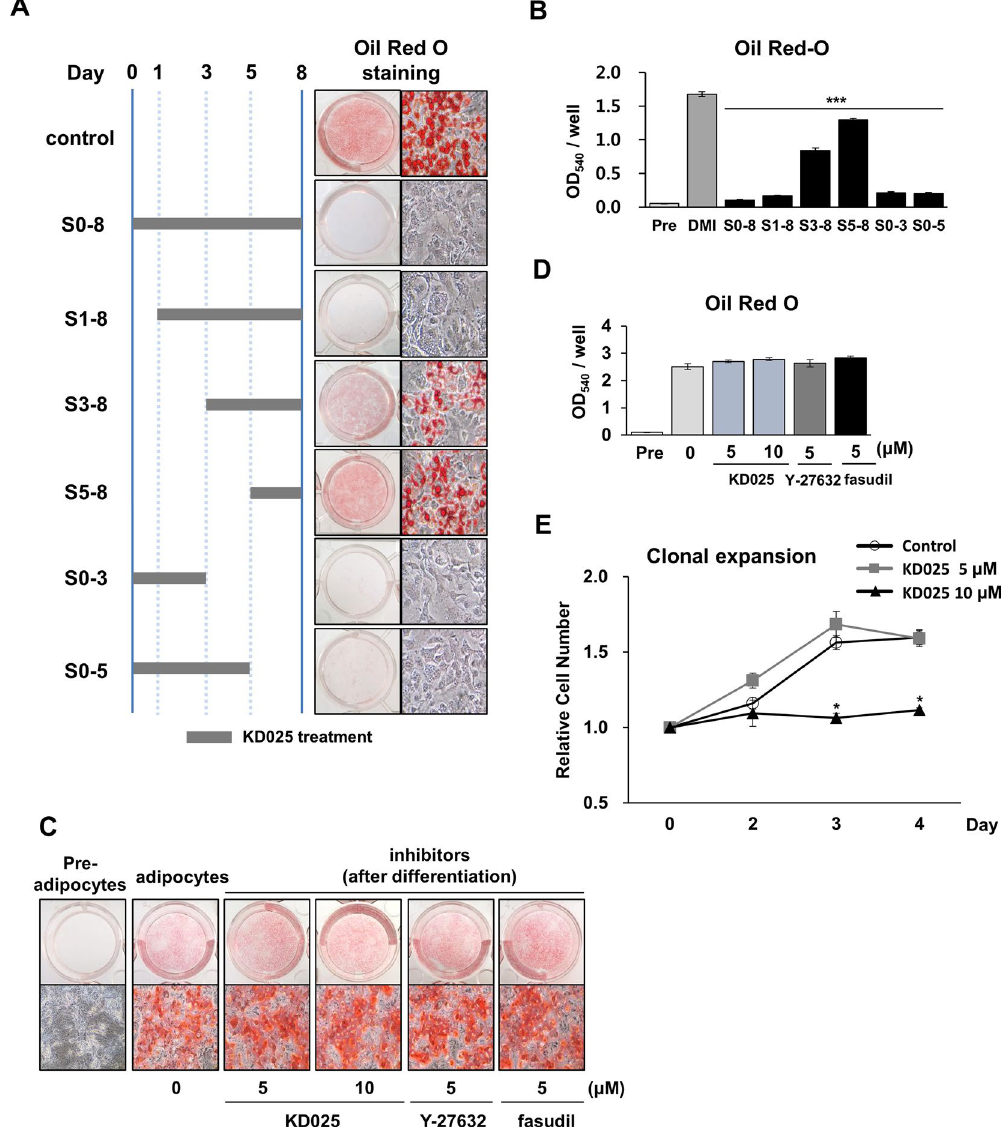
Figure 4. Phase-specific effect of KD025 on adipogenesis. ( A , B ) 3T3-L1 cells were differentiated through incubation in DMI with 5 µ M KD025 at the indicated time points and stained with Oil Red O at day 8. S0-8; KD025 was added to the growth media from day 0 to day 8, S1-8, from day 1 to day 8, S3-8, from day 3 to day 8, S5-8, from day 5 to day 8, S0-5, from day 0 to day 5. The differentiated adipocytes were stained with Oil Red O on day 8, and microscopic pictures of cells were taken. ( B ) Lipid accumulation was assessed. *** p < 0.001 vs . untreated. ( C , D ) Differentiated 3T3-L1 adipocytes (day 8) were treated with ROCK inhibitors at the concentrations indicated for 2 days, and lipid accumulation was measured. ( E ) Cells were differentiated in DMI medium with KD025 for 0, 2, 3 and 4 days, trypsinized, and counted. * p < 0.05 vs . untreated. The data are the representative from more than three independent experiments. Data are expressed as means ± S.E. based on